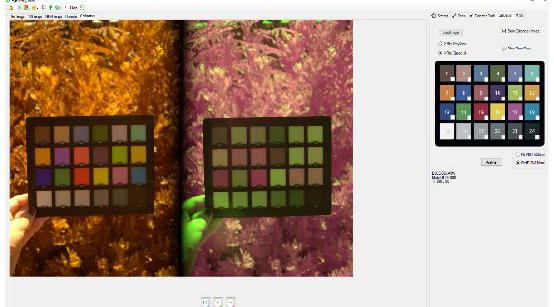
Figure 4 . Processing in the Agrowing Basic software.